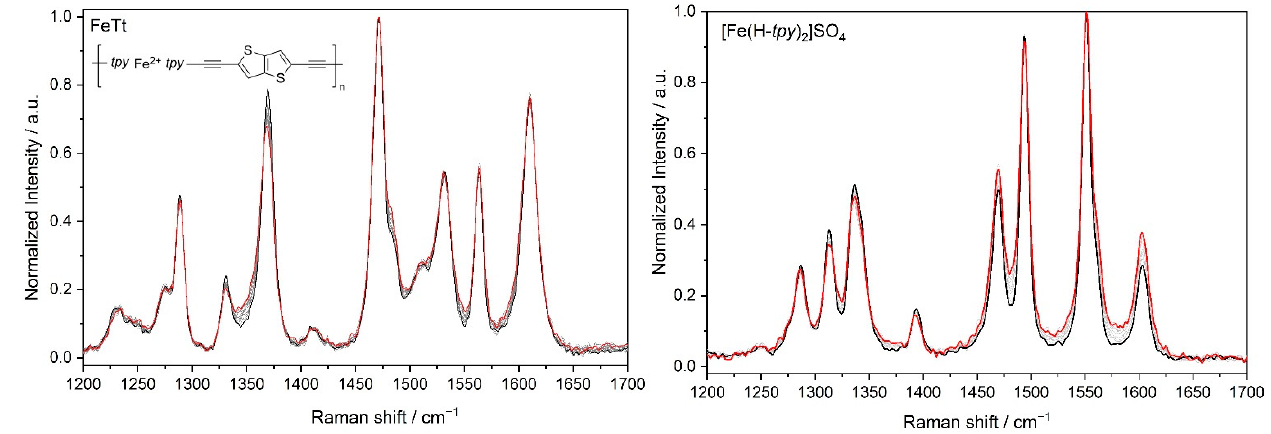
Figure 10. Overlaid baseline-corrected spectra of spectral sets of indicated compounds, normalized to the highest spectral band. Laser (532 nm) power 0.2 mW; accumulation 10 s; total time 9 min.